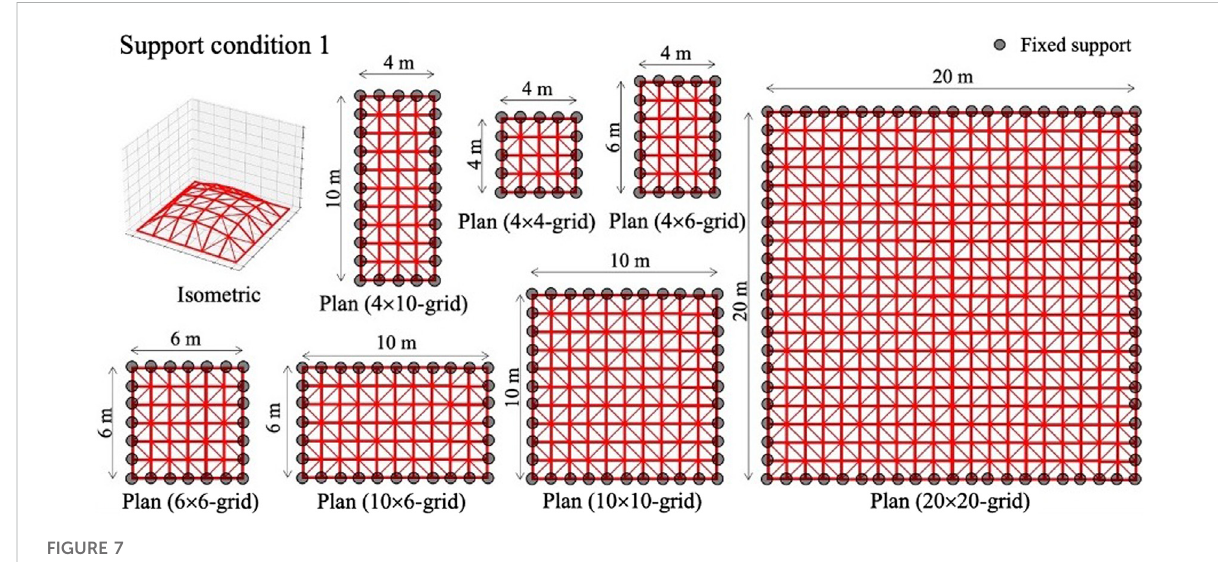
FIGURE 7 Structural models for test phase: Support condition 1.